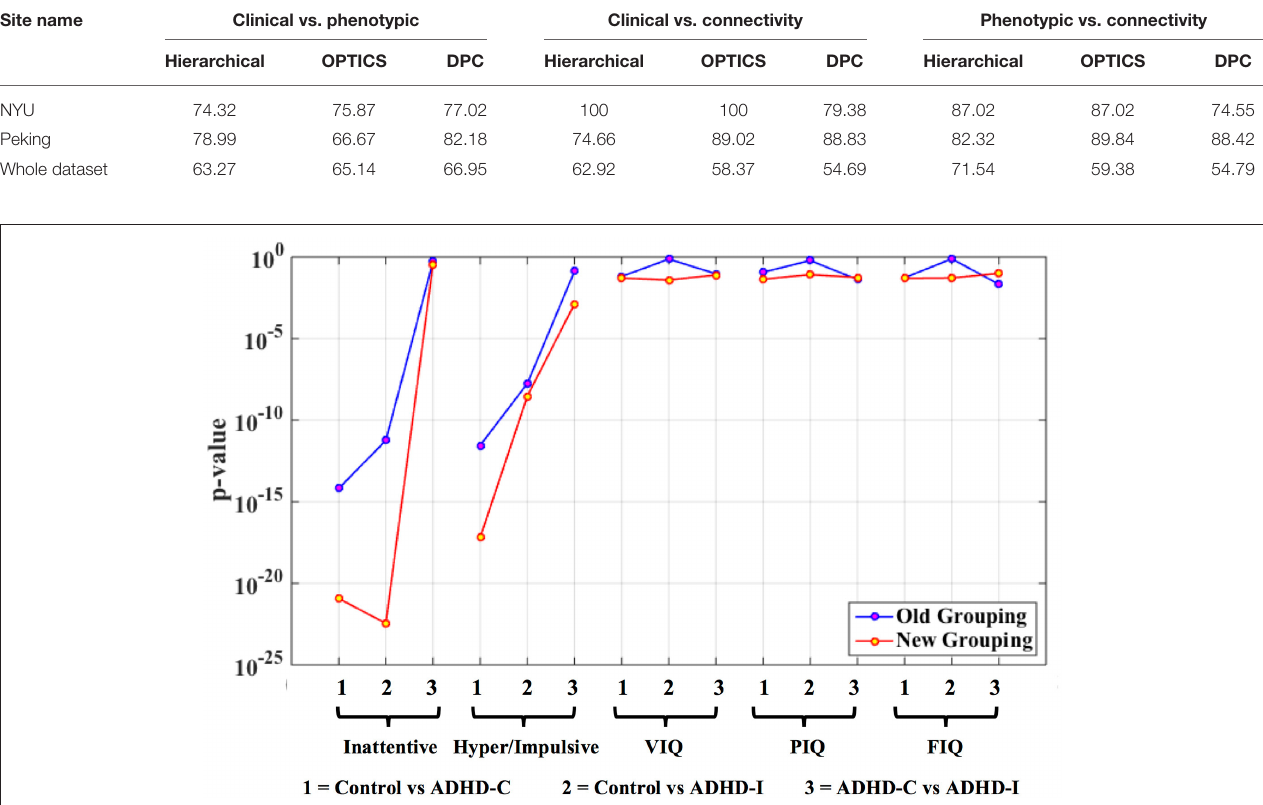
FIGURE 4 | Statistical significance ( p -value) of selected phenotypic/genotypic variables with both the traditional clinical diagnostic grouping and the new connectivity grouping. The results are shown here for the ADHD dataset. Logarithmic scale is used for the y-axis of p